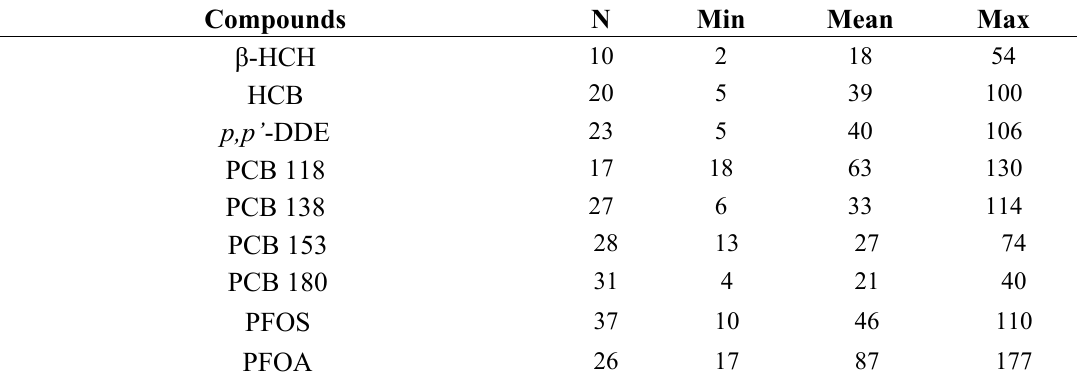
Table 4. POP ratios (%) between concentrations in fetal and maternal